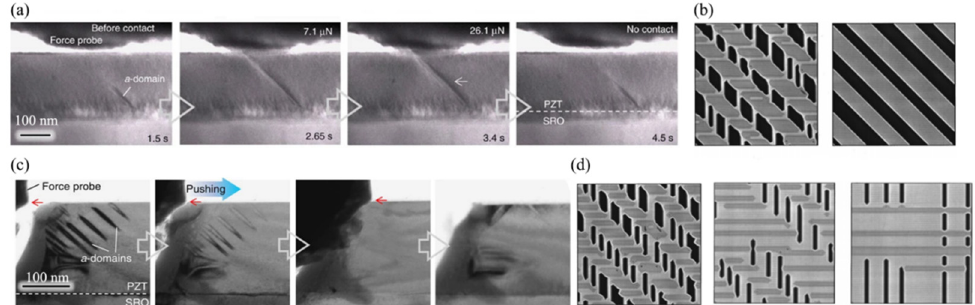
Figure 13. Domains evolution under the external mechanical stress. ( a , b ) Compressive stress along the out-of-plane direction: ( a ) the TEM images show the a-domain formation and propagation [147]; ( b ) the phase field stimulation shows the domain structures change from c/a 1 /a 2 -domain structure to a 1 /a 2 -domain structure [151]. ( c , d ) Compressive stress along the in-plane direction: ( c ) the TEM images show the a-domain shrink and disappear [147]; ( d ) the phase field stimulation shows the domain structures change from hierarchical configuration to cellular configuration [151]. Reprinted with permission from [147] 2014 Springer Nature. Reprinted with permission from [151] 2002 AIP Publishing.